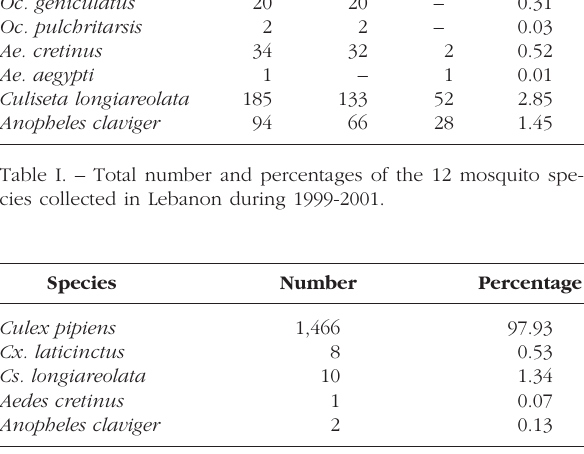
Table II. – Number and percentage of mosquito species collected indoors in the five monitored houses, during 1999-2000.